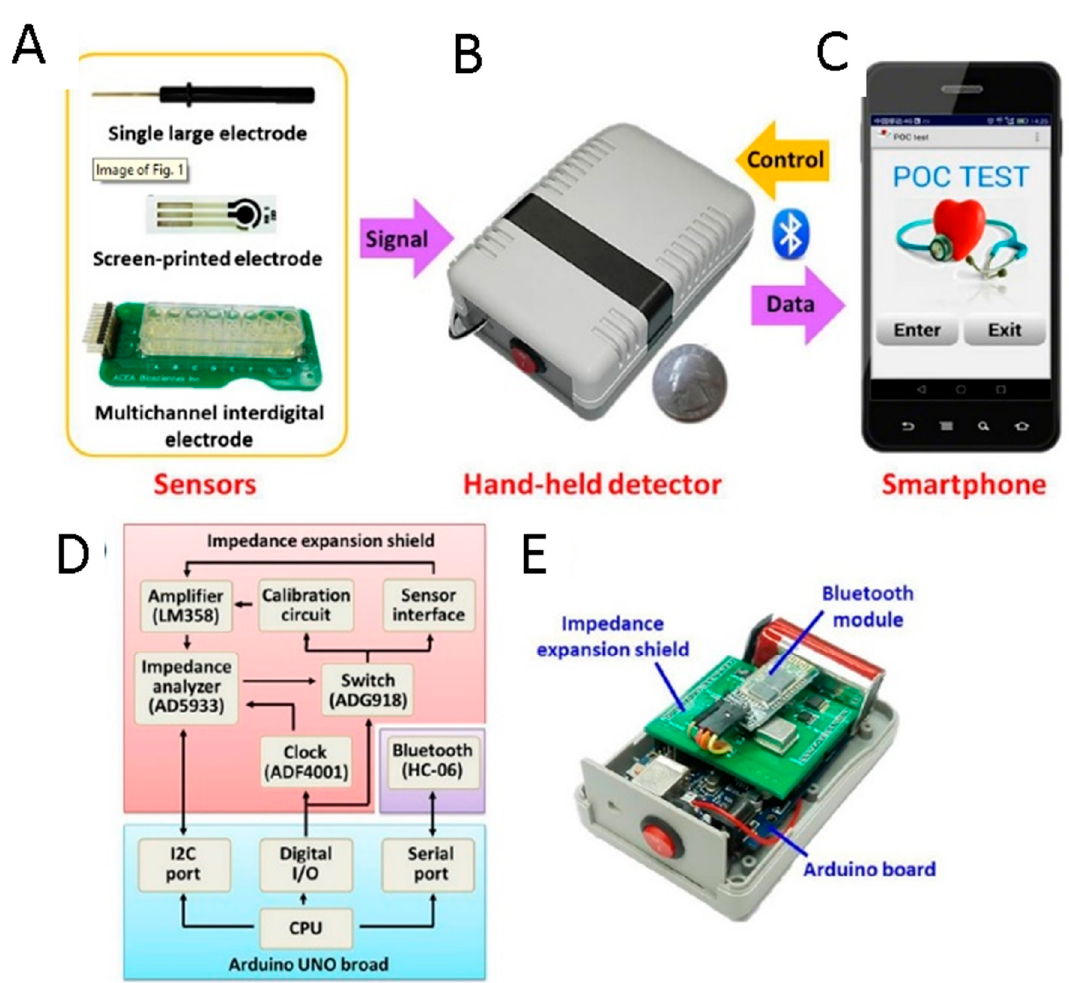
Figure 14. Smartphone-controlled electrochemical biosensor system realized by Zhang et al. The system includes electrodes (conventional large electrode, printed carbon electrodes, and interdigital gold electrodes) ( A ), a hand-held detector ( B ) and a smartphone controlling electrochemical measurements and feeding back signals ( C ) integrated in a circuit ( D ) by communicating with an impedance shield included in the hand-held detector through an Arduino board ( E ). Modified with permission from [136].